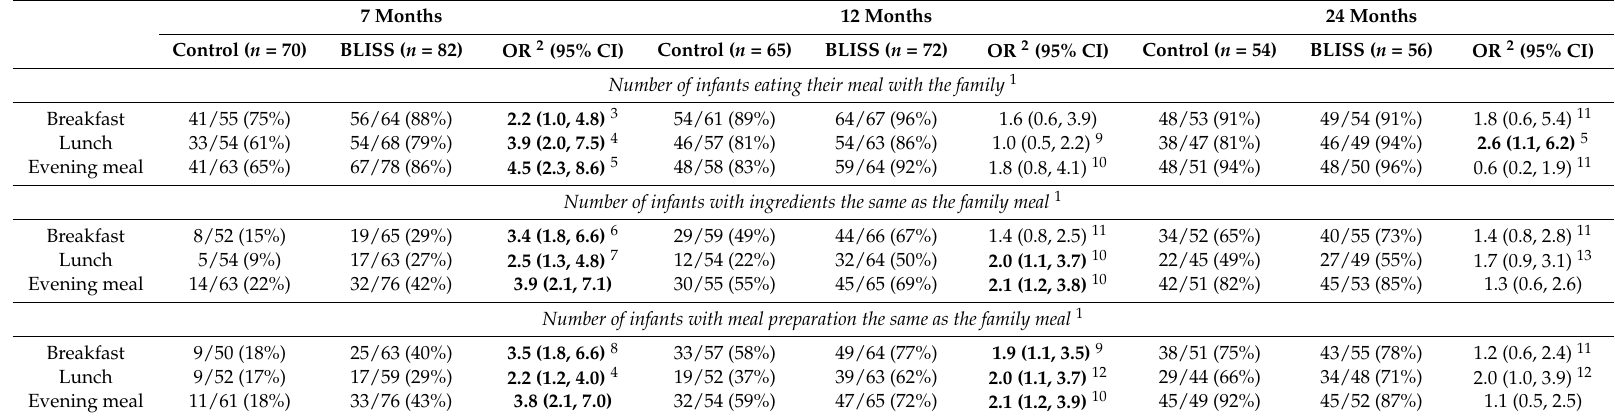
Table 3. Relationship between the foods eaten by the infant and the meals eaten by their family (i.e., family